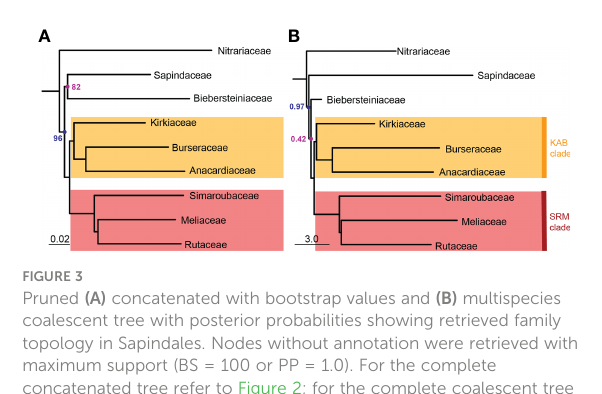
FIGURE 3 Pruned (A) concatenated with bootstrap values and (B) multispecies coalescent tree with posterior probabilities showing retrieved family topology in Sapindales. Nodes without annotation were retrieved with maximum support (BS = 100 or PP = 1.0). For the complete concatenated tree refer to Figure 2; for the complete coalescent tree refer to Supplementary Material 5. The scale bar in (A) denotes the expected number of substitutions per site; in (B) it corresponds to coalescent units for internal branches (not terminal branches). Note that Biebersteiniaceae only comprised one sample, resulting in the short branch length on the multispecies coalescent